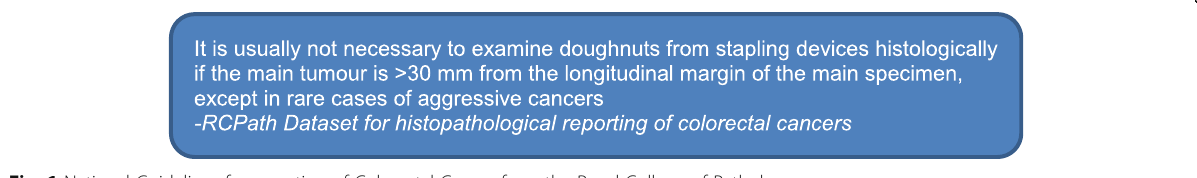
Fig. 1 National Guidelines for reporting of Colorectal Cancer from the Royal College of Pathology